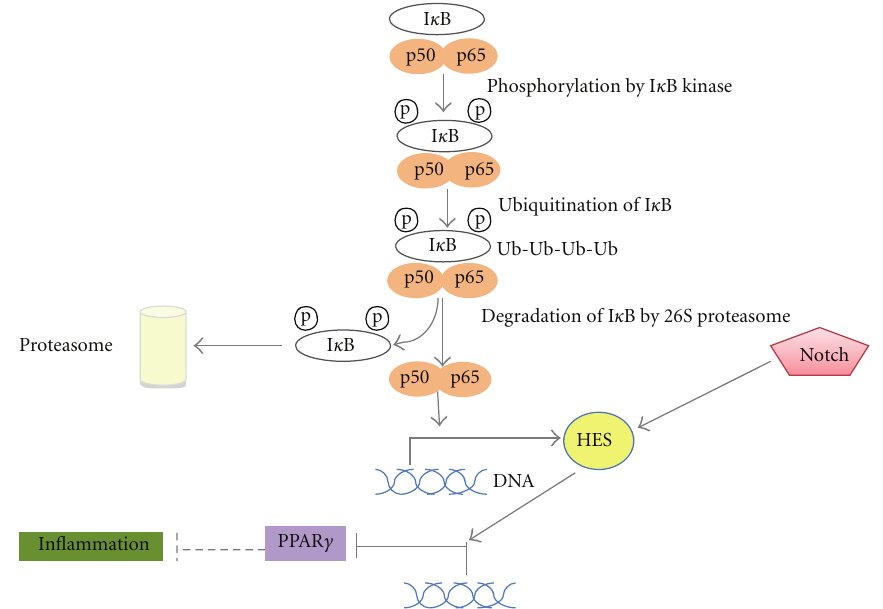
Figure 5: A schematic representation of the role of PPAR γ and UPS in inflammation. UPS regulates NF- κ B (here subunits p65 and p50 are depicted) in multiple points, one of which is degradation of inhibitor I κ B. Activated NF- κ B cooperates with Notch in the induction of Hes. Hes is a transcriptional repressor of PPAR γ and thus inflammation is promoted.